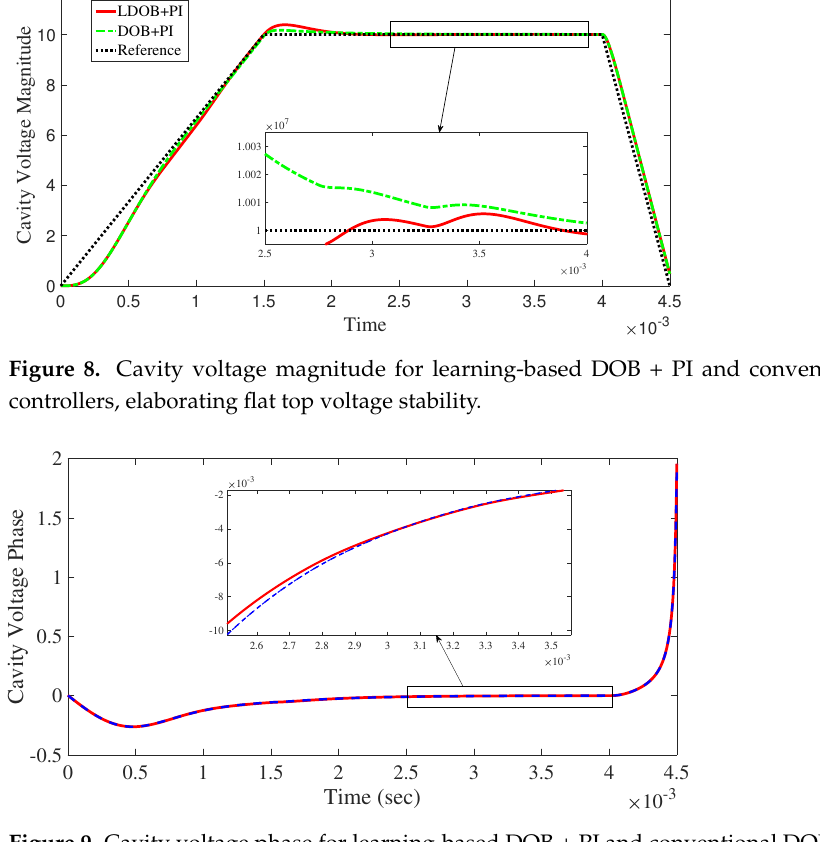
Figure 9. Cavity voltage phase for learning-based DOB + PI and conventional DOB + PI controllers, elaborating phase stability during flat